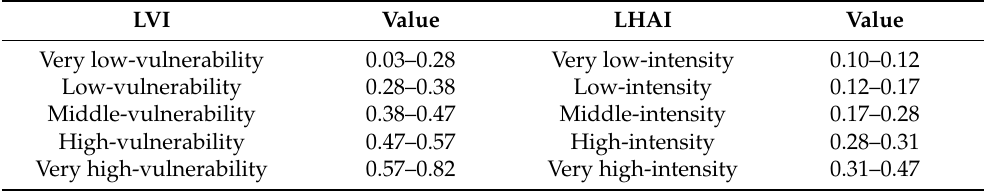
Table 2. Classification statistics according to LVI and LHAI in Ganzi